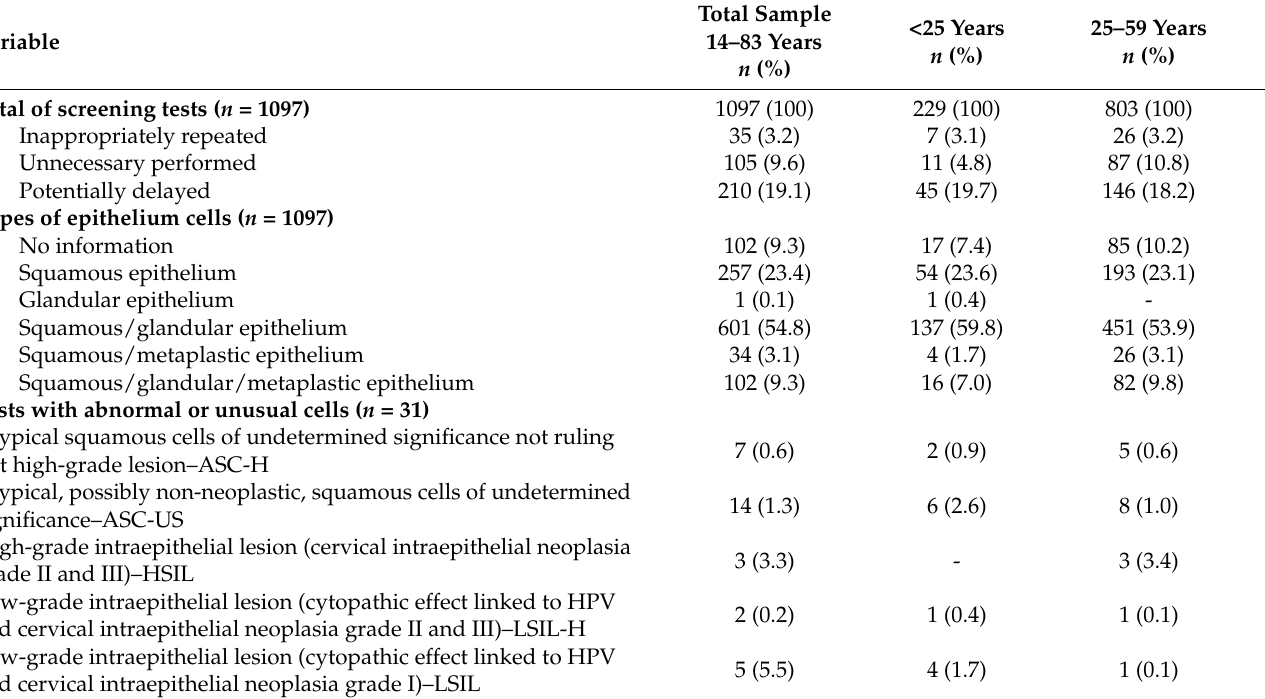
Table 4. Administrative data on Pap smear tests performed on the study population from January 2016 to May 2019, types of cells, and results by age